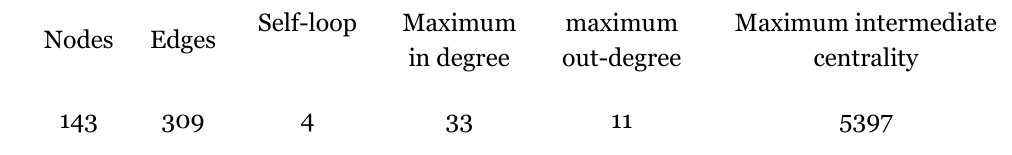
The Overall Metrics of Social Networking in the First Week of Blog-Based Interaction Self-loop Nodes Edges